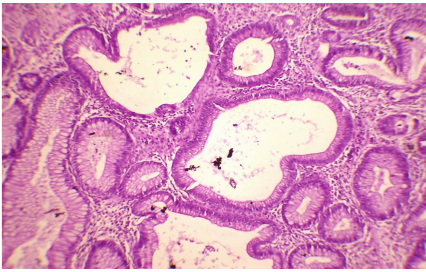
Figure 8: Biopsy showing adenomatous changes with stromal edema and dilated glands.